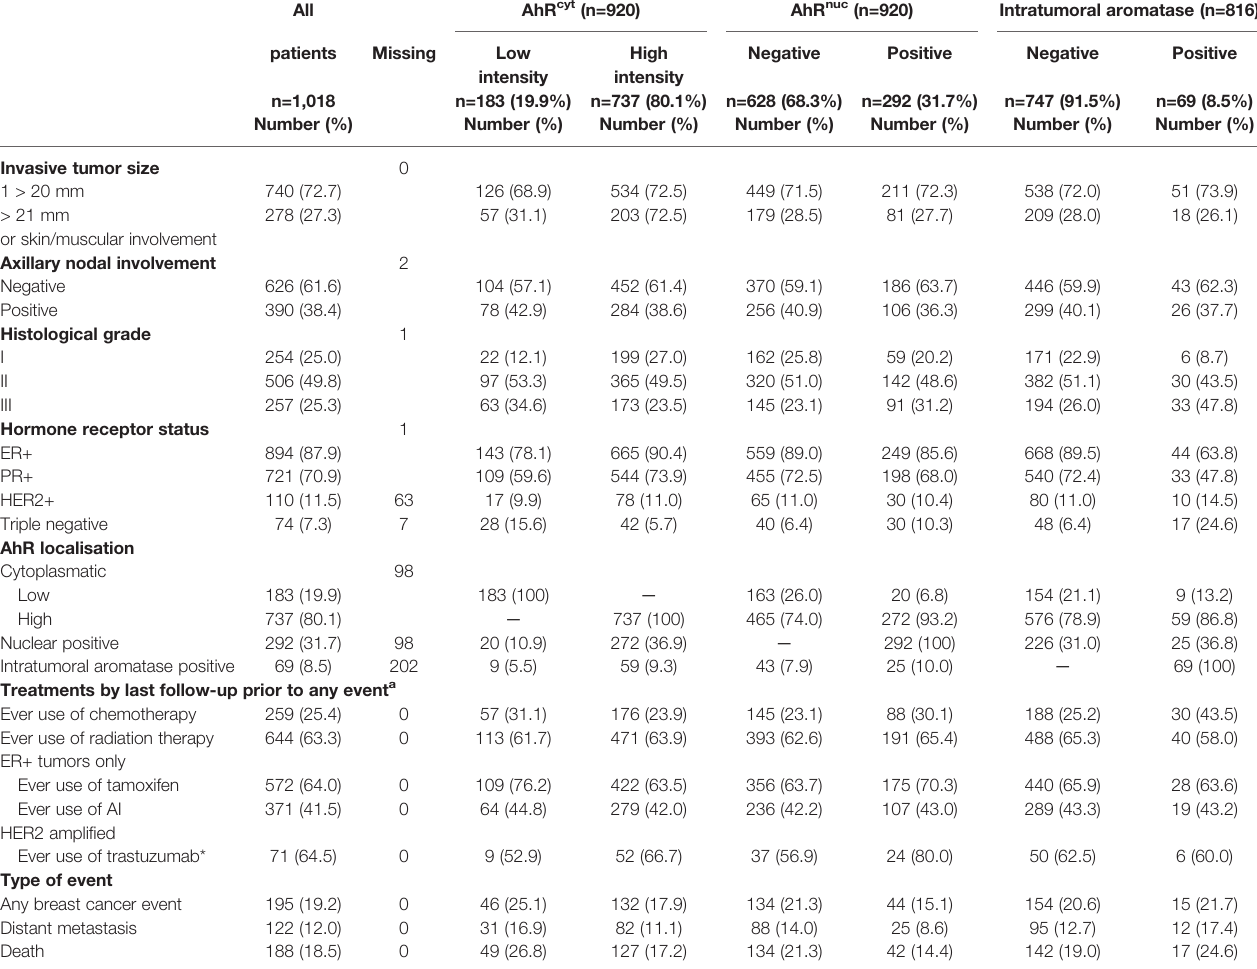
TABLE 2 | Tumor characteristics, treatments, and events in relation to AhR cyt , AhR nuc , and intratumoral aromatase levels.